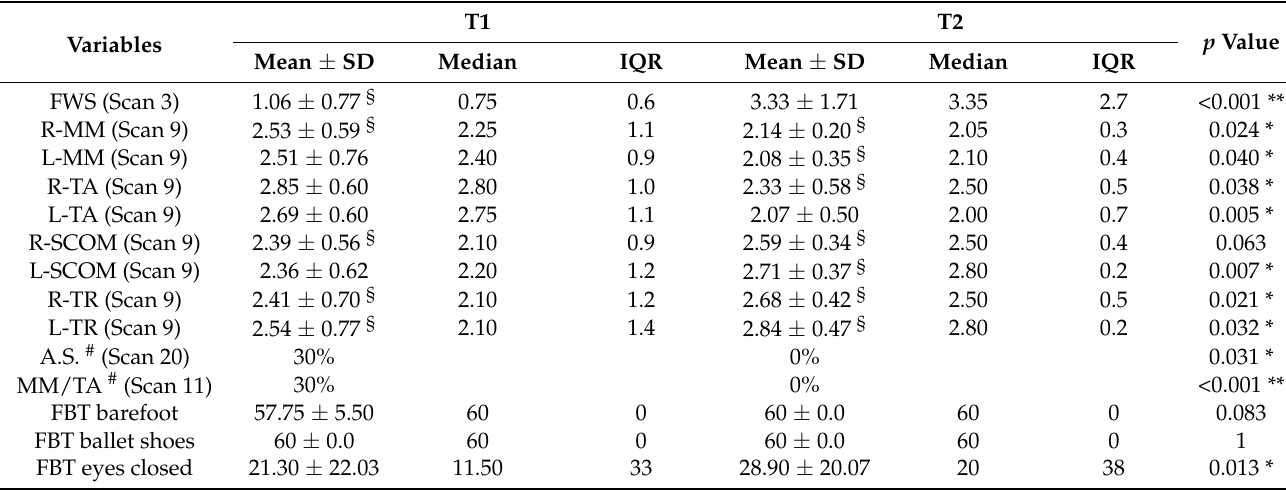
Table 1. Statistical comparison of the electromyographic (EMG) and kinesiographic values before and after trans-electrical nerve stimulation (TENS) and orthotic